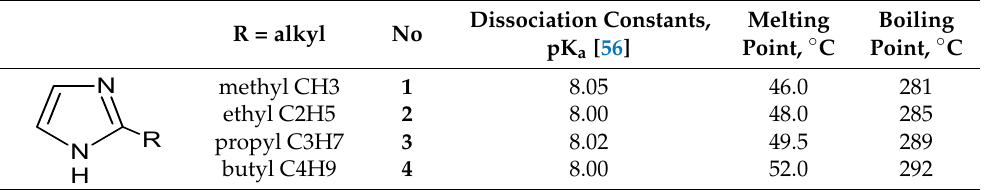
Table 1. The general formula of the 2-alkylimidazoles used in the tests and some of their physicochemical properties.